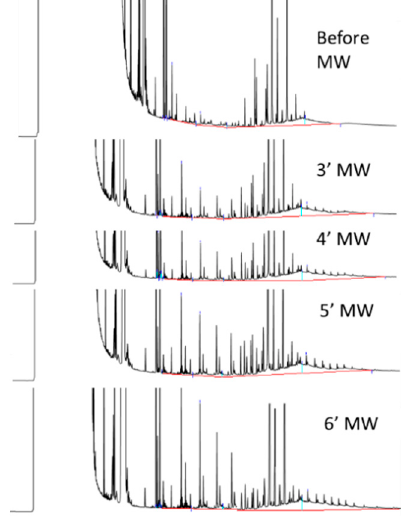
Figure 8. Effect of different heating times on POH migration. Figure 8. E ff ect of di ff erent heating times on POH